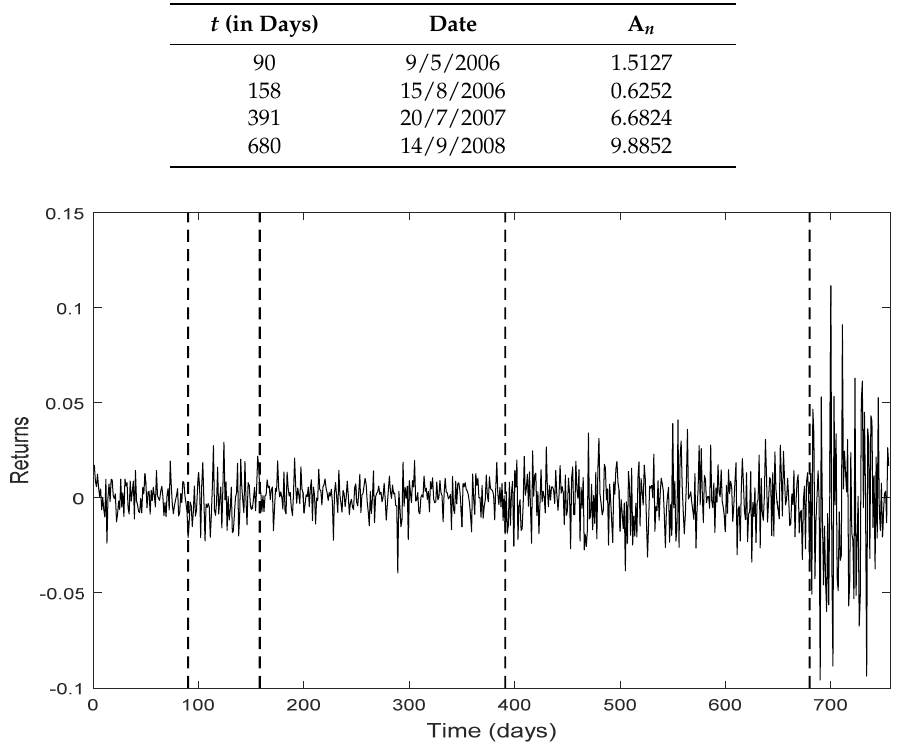
Table 3. Change points for NASDAQ index with the corresponding test statistic value.